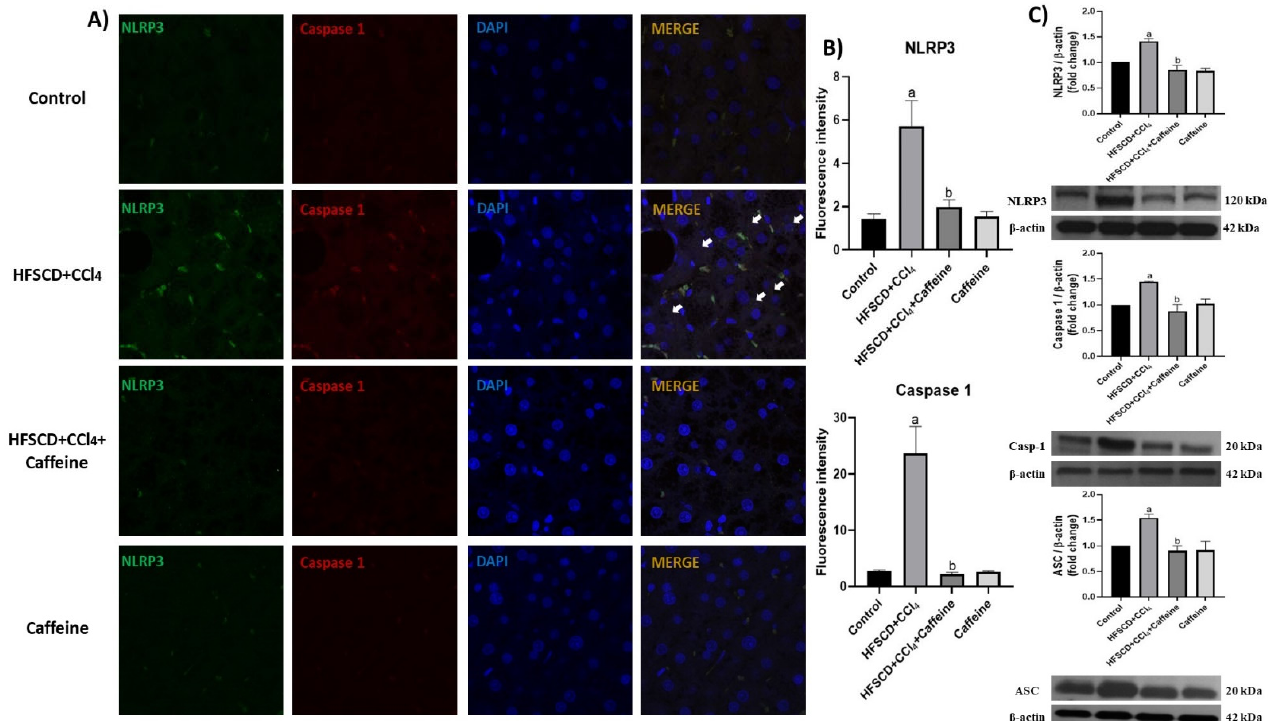
Figure 5. Effect of caffeine on NLRP3 inflammasome activation in hepatic tissue from the NASH model. ( A ) IF analysis of NLRP3/caspase 1 in hepatic tissues from rats in the control, HFSCD+CCl 4 , HFSCD+CCl 4 +caffeine, and caffeine groups. White arrow = Colocalization between NLRP3 inflam- masome and pro-caspase-1 marks. ( B ) IF intensity quantification of NLRP3 and caspase-1 (n = 3). ( C ) Levels of NLRP3, caspase-1, and ASC proteins detected using western blot (n = 3); β -actin was used as a loading control. Values are shown as a fold increment in optical density normalized to control group values (control = 1). Bars represent the mean ± SEM. (a) p < 0.05 compared with the control group; (b) p < 0.05 compared with the HFSCD+CCl 4 group. The slides were observed under a confocal microscope at 63× magnification.